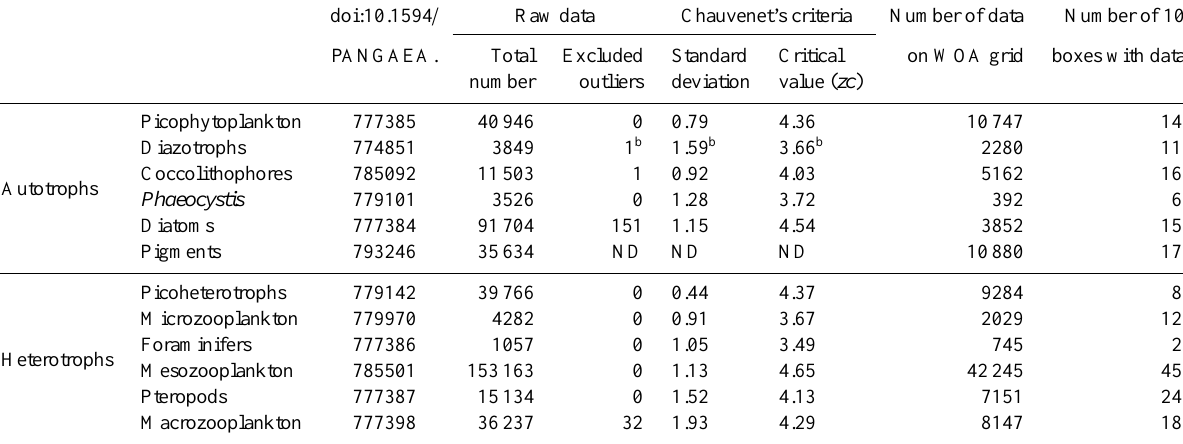
Table 1. Database